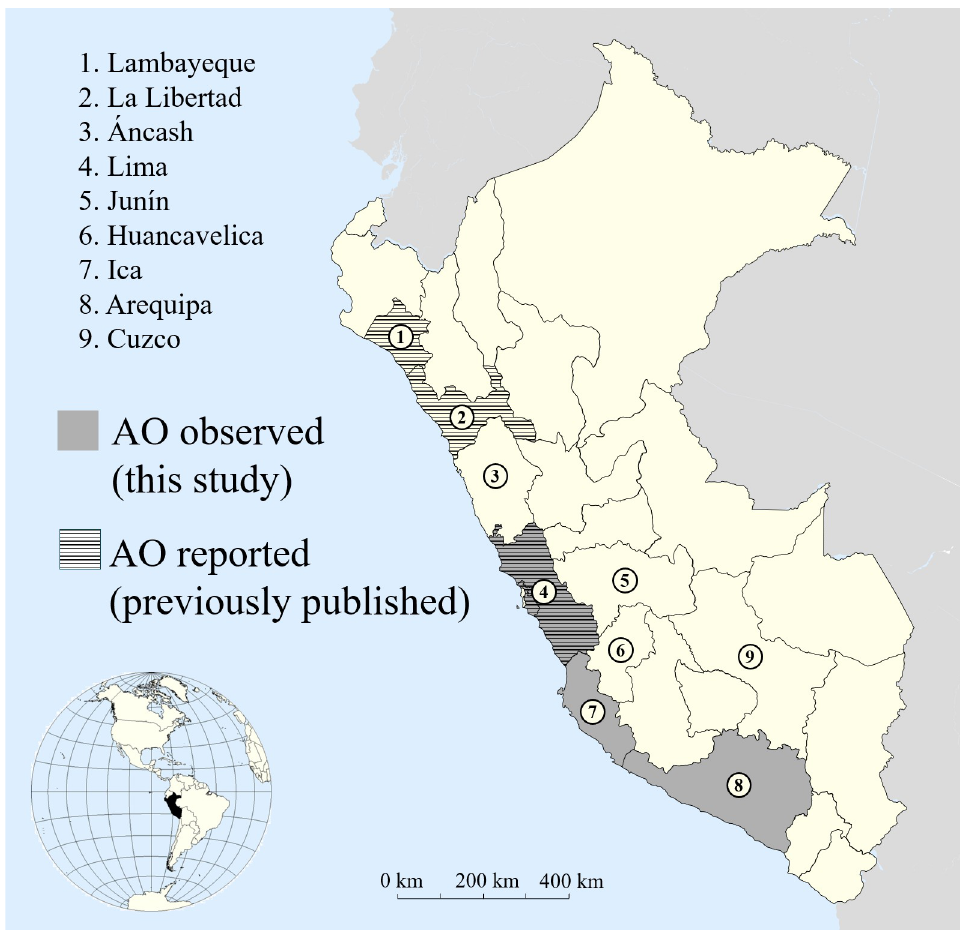
Fig 1. Geographical distribution of atlas occipitalization (AO) across Peru. Crania examined for this study were from regions 2–9, with AO observed in regions 4, 7, and 8 (in gray). Previous reports of AO (in stripes) come from Verano [4] in region 1 and Barnes [3] in regions 2 and 4. This figure is a derivative of “Blank map of South America” by Camilo Sanchez and “Western Hemisphere of Earth (Lambert Azimuthal projection)” by Sean Baker, which are licensed under CC BY 3.0 and 2.0, respectively.